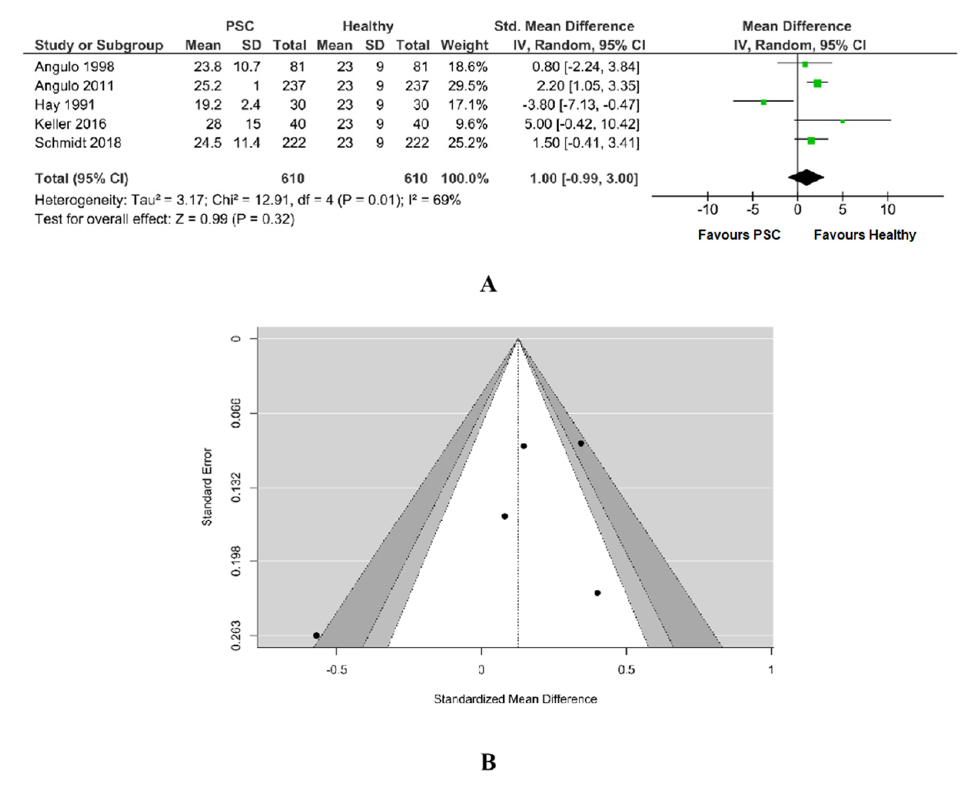
Figure 7. ( A ) Forest plot assuming a random-effects model for Vitamin D PSC vs. Healthy. ( B ) Funnel plot for publication bias assessment for vitamin D in PSC patients vs. Healthy [19,29,31–33]. Egger’s regression value ( − 1.343) and its p -value (0.179) together with its Rank cor- relation test value ( − 0.600) and its p -value (0.233) did not indicate any funnel plot, as in Figure